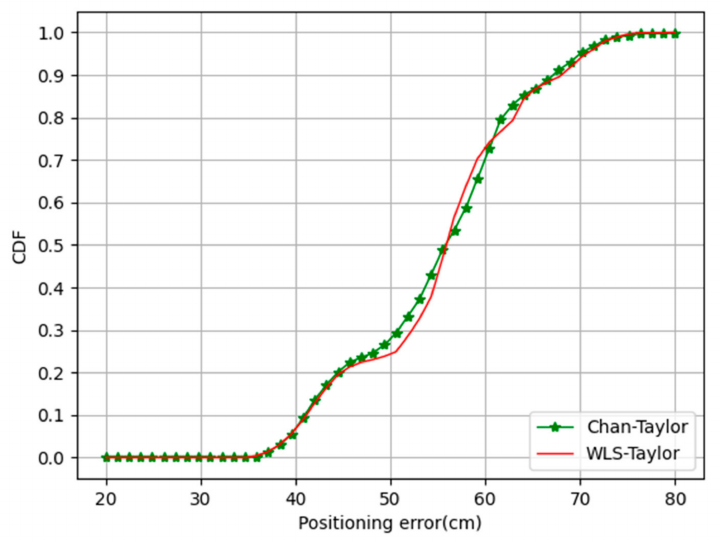
Figure 6. Positioning error of the Chan–Taylor algorithm and the WLS-Taylor